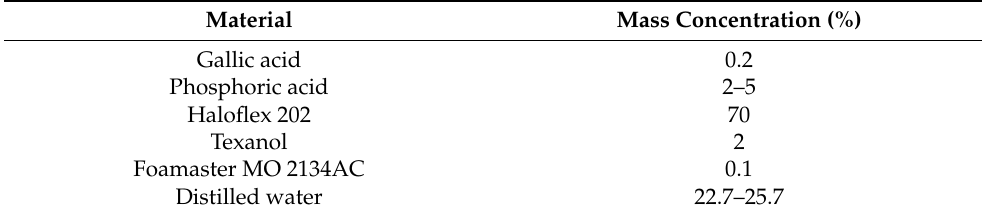
Table 1. Coating